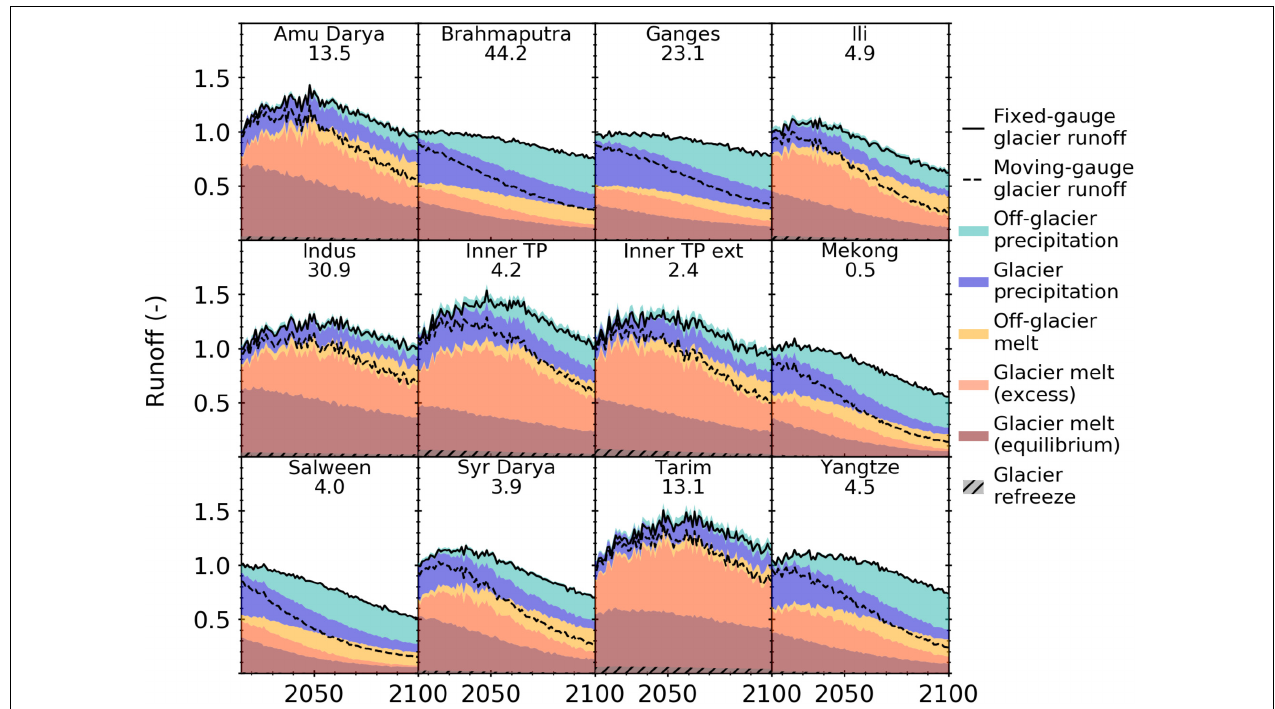
FIGURE 8 | Multi-GCM mean of annual fixed-gauge glacier runoff and the relative contribution from various components for RCP 4.5 from 2015 to 2100 relative to the mean annual fixed-gauge glacier runoff from 2000 to 2015 (given below region name in Gt yr - 1 ). Results for RCP 2.6, RCP 6.0, and RCP 8.5 are shown in the Supplementary Figures S7–S9